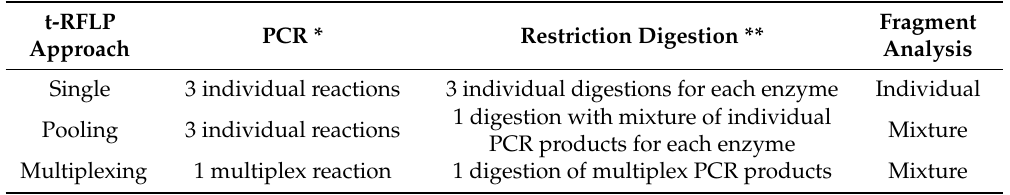
Table 2. Outline of the Terminal Restriction Fragment Length Polymorphism (t-RFLP) analysis